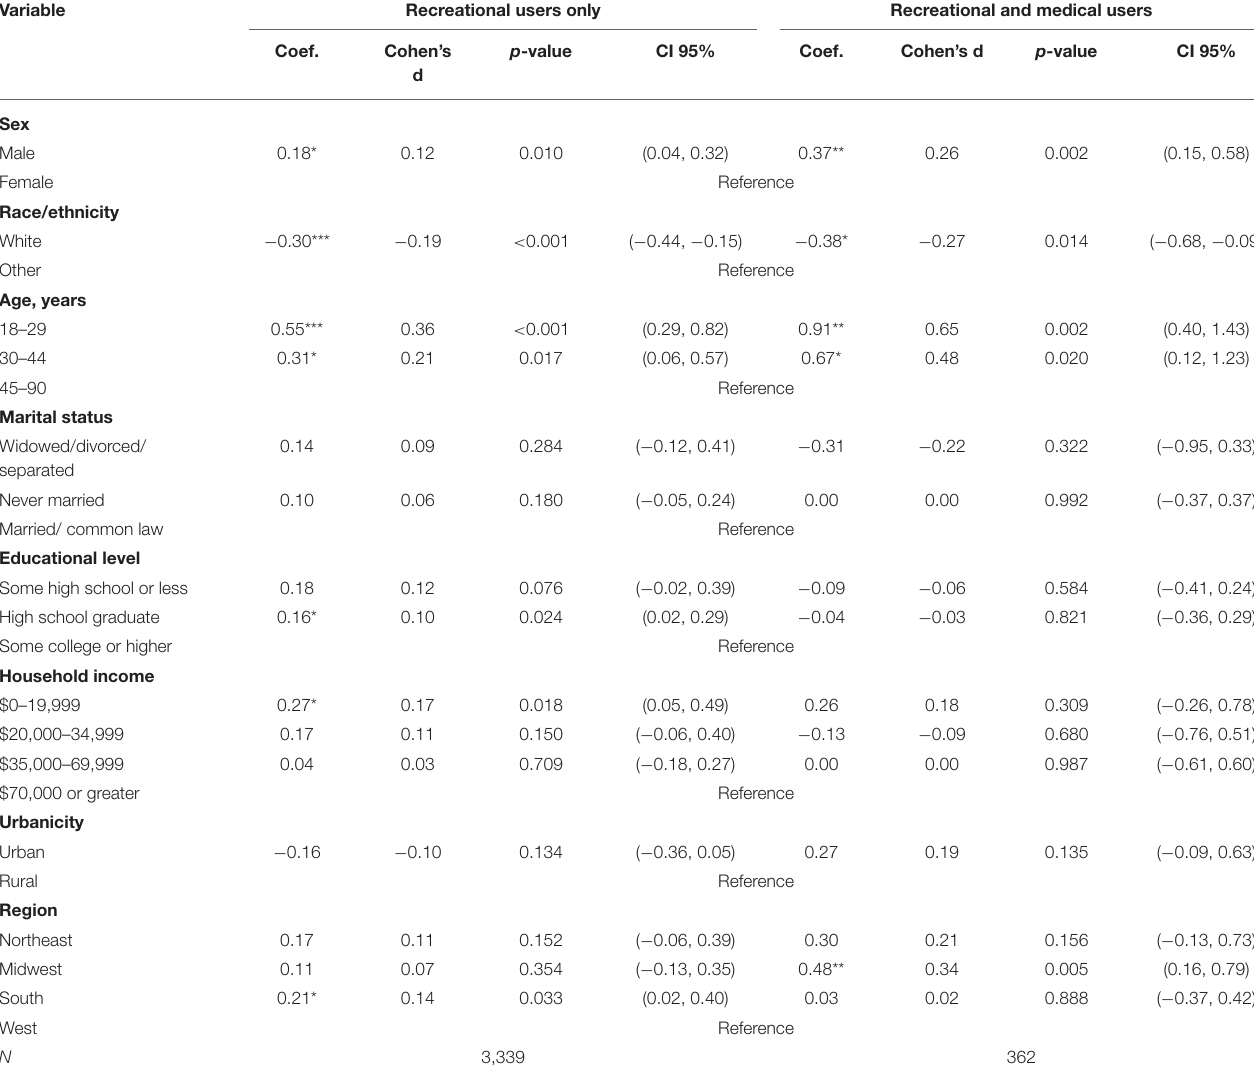
TABLE 3 | Association between respondents’ sociodemographic characteristics and number of past-year cannabis use disorder criteria (Diagnostic and Statistical Manual of Mental Disorders, Fifth Edition).